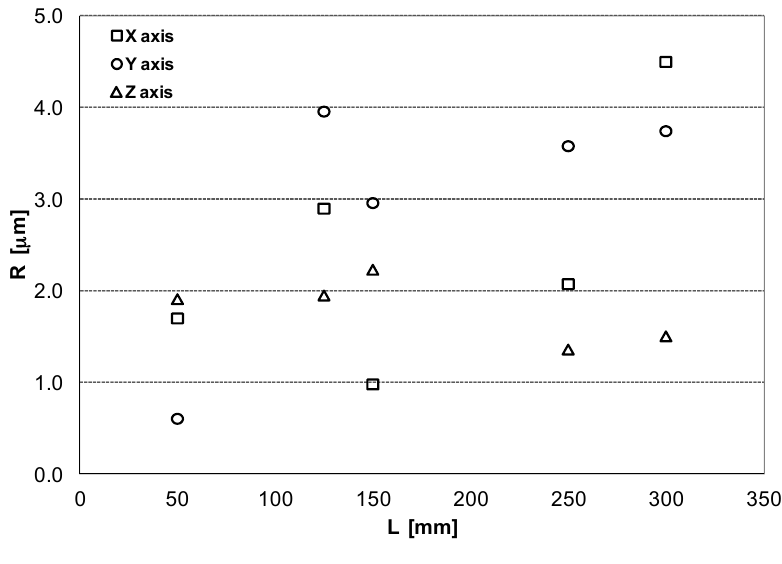
Figure 6. CMM repeatability R 0 by axis.